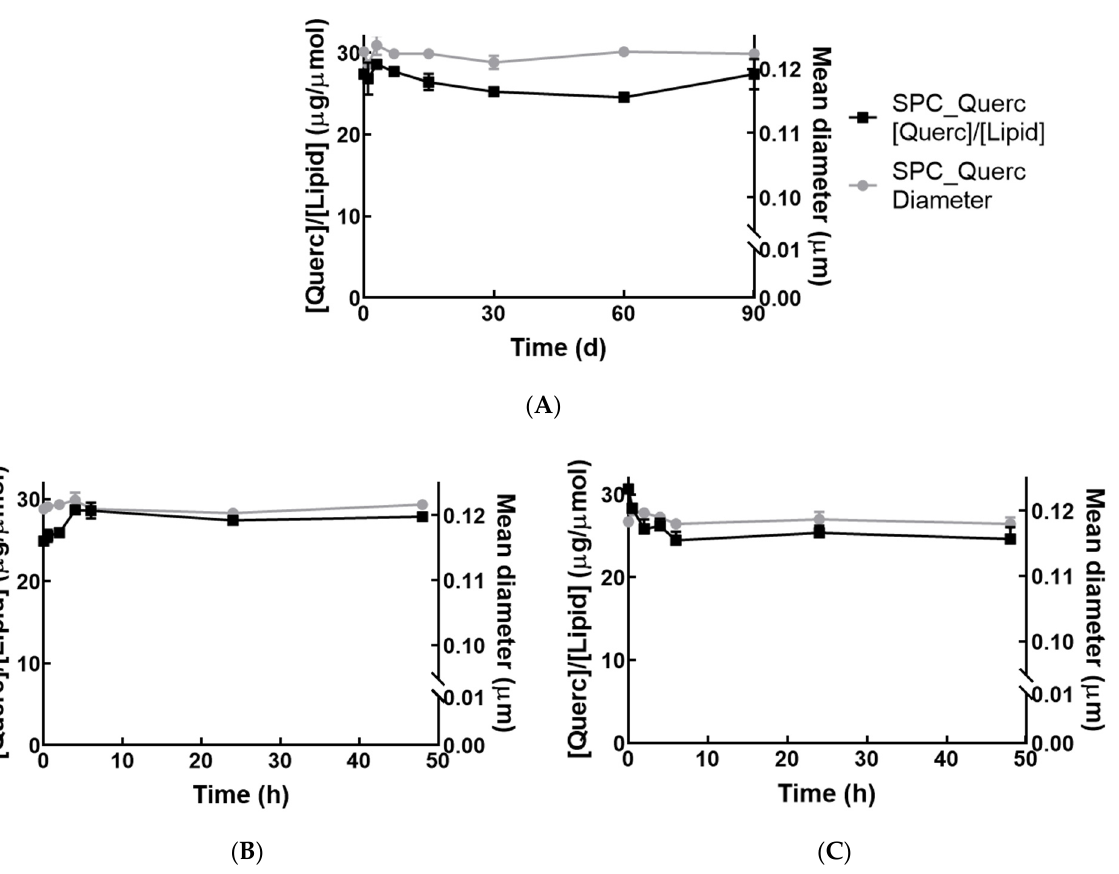
Figure 2. Stability of quercetin liposomes. Stability of SPC_Querc at 4 °C in citrate buffer ( A ) or at 37 °C in citrate buffer without ( B ) or with 1% ( w / v ) BSA ( C ). Values of the loading capacity (quercetin-to-lipid ratio, [Querc]/[Lipid]) and mean diameter are represented as mean ± SD ( n = 3). In the developed IR in vitro model, during hypoxia period, HepG2 cells were incu- bated with complete medium or with DMEM without any supplement (simple